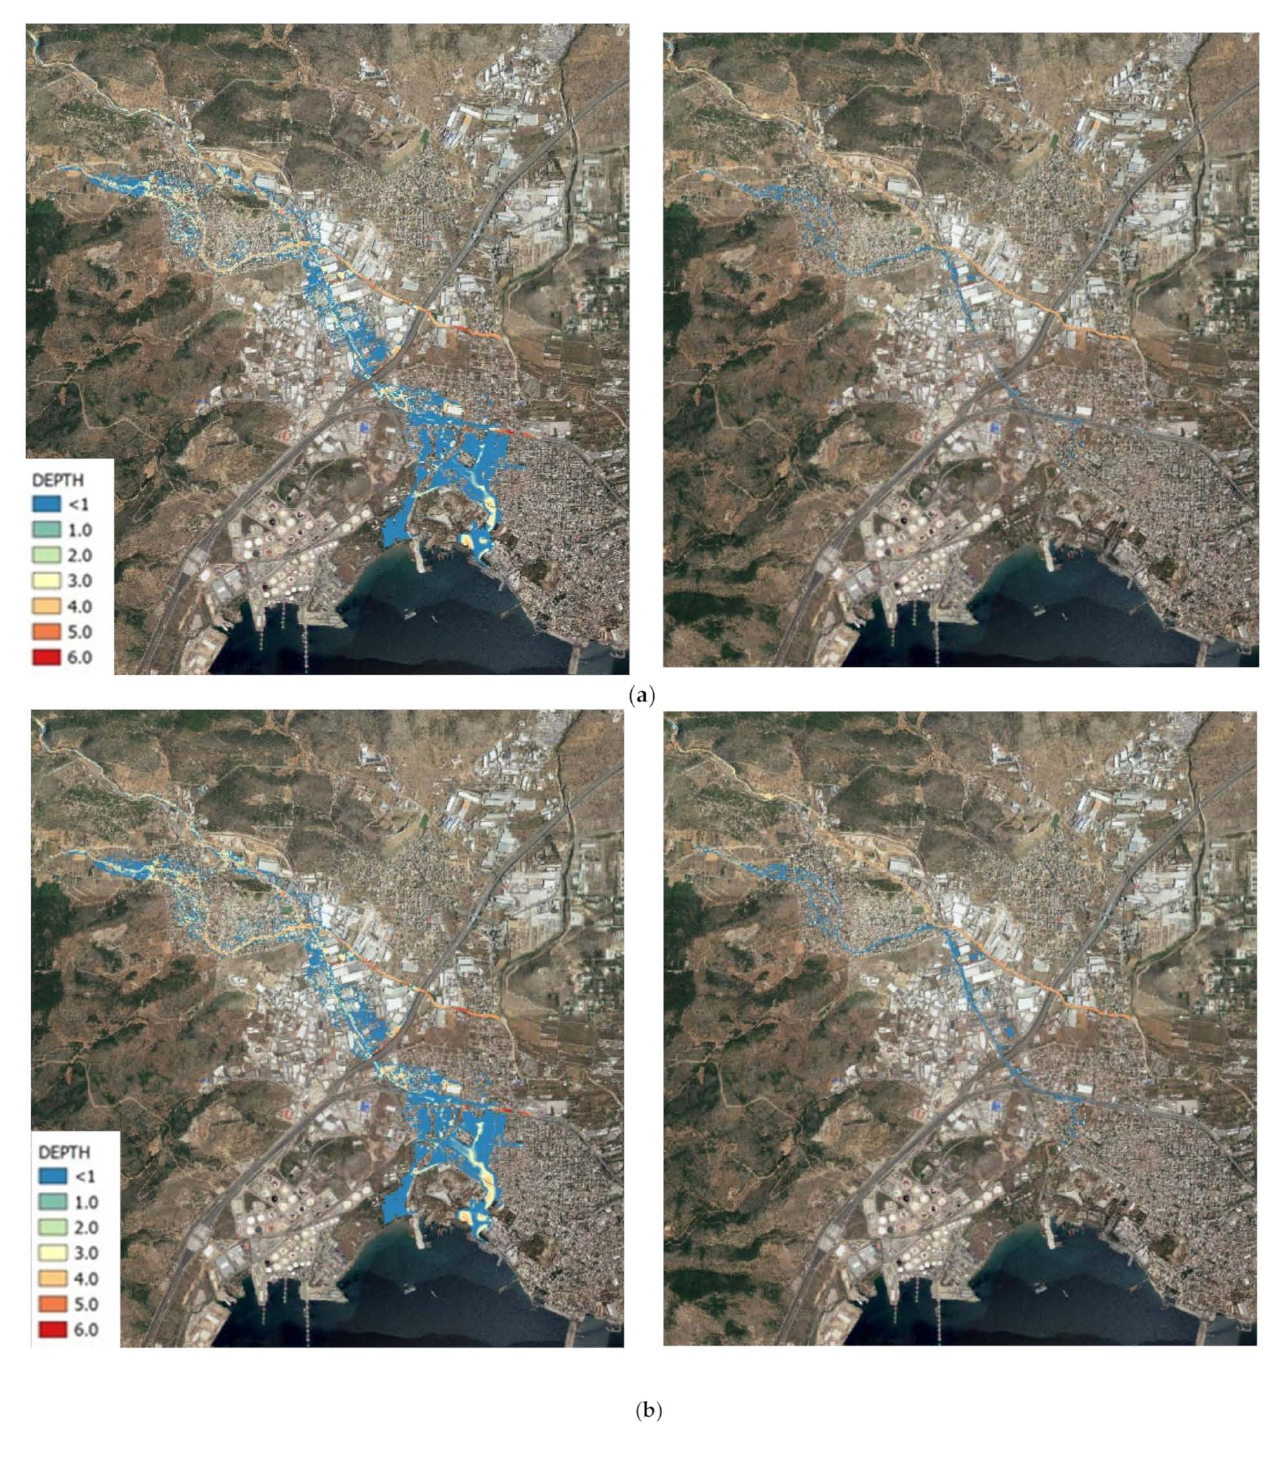
Figure 5. Maximum water depths (m) for 4 indicative scenarios: ( a ) Scenarios S20-06 ( left ) and W20-06 ( right ) for T = 20 y and t = 6 h. ( b ) Scenarios S200-18 ( left ) and W200-18 ( right ) for T = 200 y and t = 18